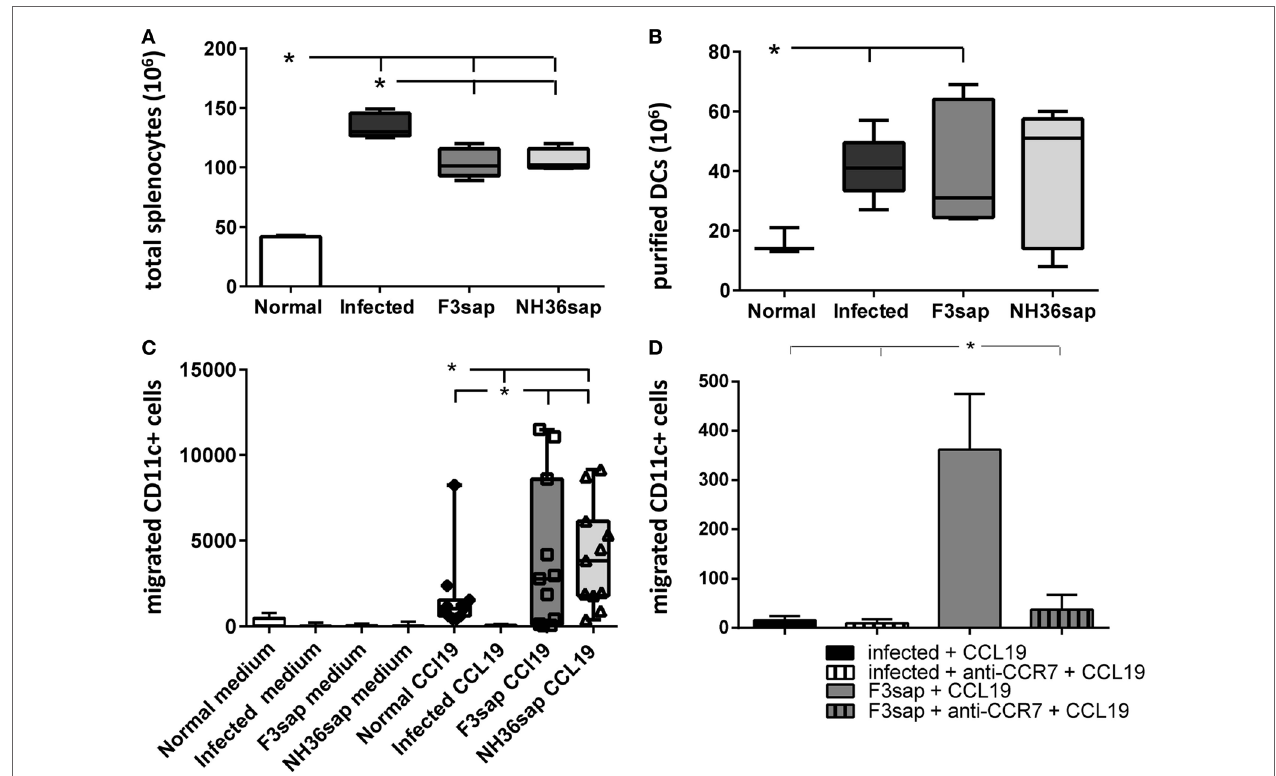
FigUre 2 | F3- and NH36-primed dendritic cells (DCs) show enhanced migration response to CCL19 chemokine. Splenic DCs were purified from, normal, infected and F3, and NH36-vaccinated and Leishmania infantum chagasi -challenged mice. DCs were isolated at day 28 after challenge. The whiskers show the maximal and minimum values, and the top and bottom of the bars show respectively, the 75th and 25th percentiles. The 75th percentile is the value below which 75% of observations in a group of observations fall. (a) Total splenocytes. (B) Number of DCS purified by magnetic beads-affinity chromatography. (c) The chemotactic responses to 100 η M CCL19 were assessed using a transwell system. After 2 h of incubation, migrated DCs were collected, stained using fluorescein isothiocyanate-conjugated anti-CD11c antibody, and counted by flow cytometry in a FacsCalibur apparatus (Becton Dickinson). In the boxes, the individual results for migrating DCs counts of normal mice (diamonds), F3-vaccinated (squares), and NH36-vaccinated mice (triangles). (D) Number of DCs from infected or F3-vaccinated and challenged mice, pre-incubated with anti-CCR7 antibody or no addition, which migrated toward CCL19. Results represent two-independent experiments ( n = 5–6, mice per treatment in each experiment). Asterisks and horizontal lines show significant differences between treatments as disclosed by Mann–Whitney non-parametrical